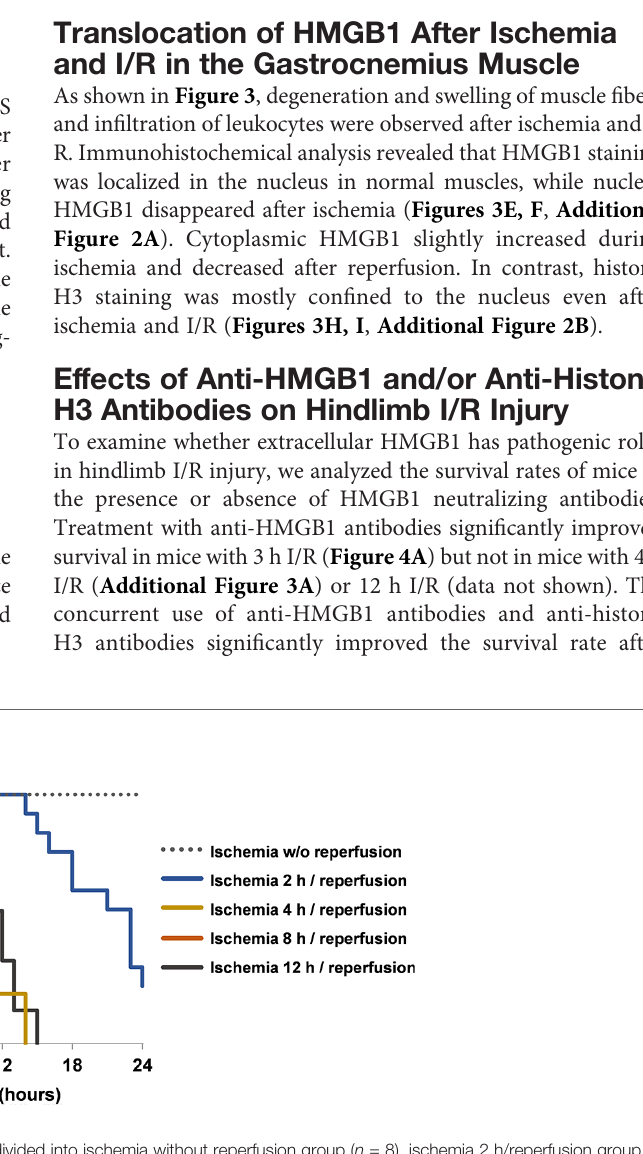
FIGURE 1 | Survival rates of mice with ischemia and reperfusion. Mice were divided into ischemia without reperfusion group ( n = 8), ischemia 2 h/reperfusion group ( n = 13), ischemia 4 h/reperfusion group ( n = 10), ischemia 8 h/reperfusion group ( n = 13) and ischemia 12 h/reperfusion group ( n = 15). Their survival rates were investigated up to 24 h after reperfusion. Cumulative data of two or more independent experiments are shown. w/o,